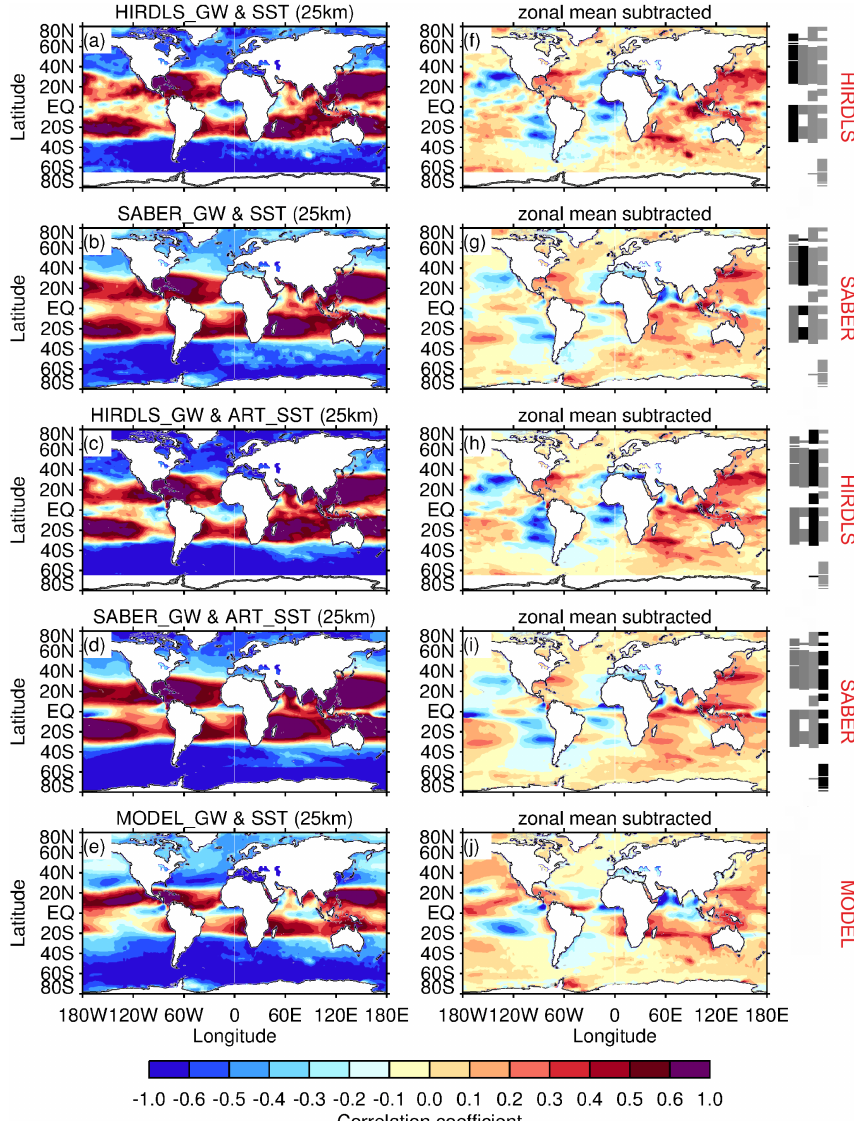
Figure 2. Global maps of correlation coefficients from temporal correlations. Correlation between time series of GWMF and of SST from various sources are calculated and presented in the left column. The middle column shows corresponding maps after zonal detrending. On the right side of the maps, an indication of confidence is given which represents the influence of sources on the distribution (cf. Sect. 4.3 and Fig. 3). In each row the indication bar deduced from the map in the middle column of this row is highlighted in black. The first row (a, f) shows correlations between HIRDLS GWMF and SST, the second row (b, g) shows correlations between SABER GWMF and SST, the third row (c, h) presents correlations between HIRDLS GWMF and artificial SST, the fourth row (d, i) presents correlations between SABER GWMF and artificial SST and, finally, the fifth row (e, j) shows correlations between a GROGRAT simulation and SST. For details see